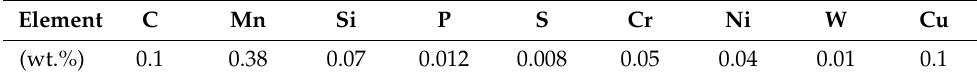
Table 1. Chemical composition of TRISTAL